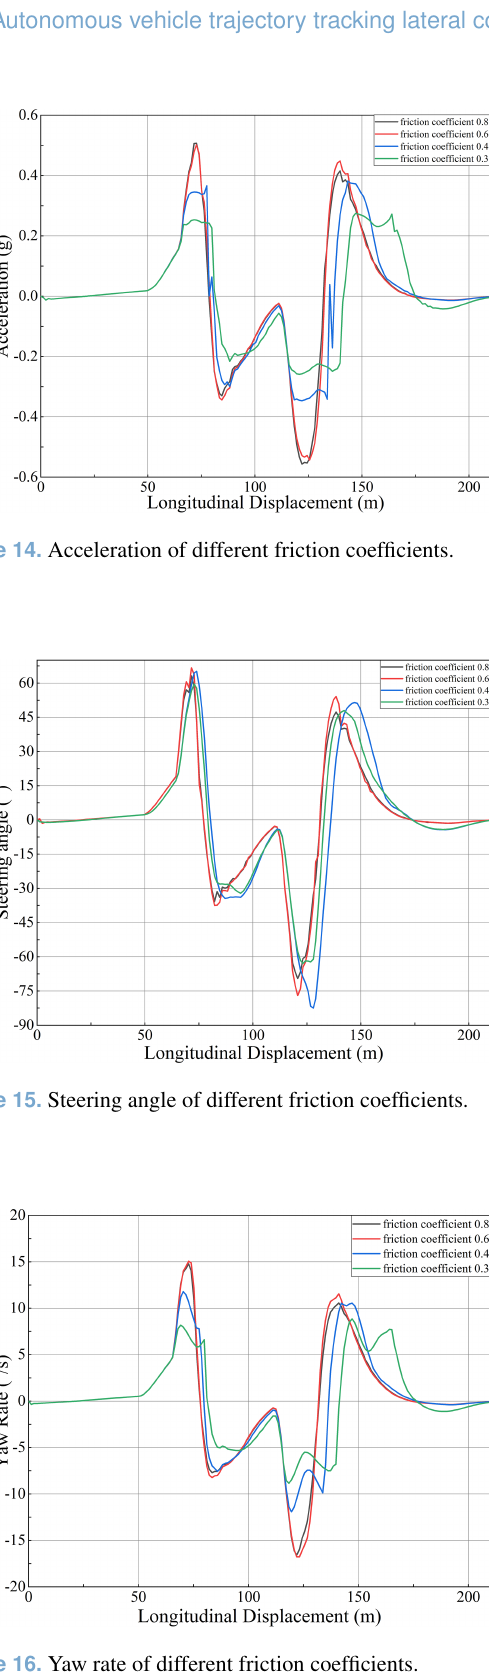
Figure 13. Trajectory tracking of different friction coefficients.